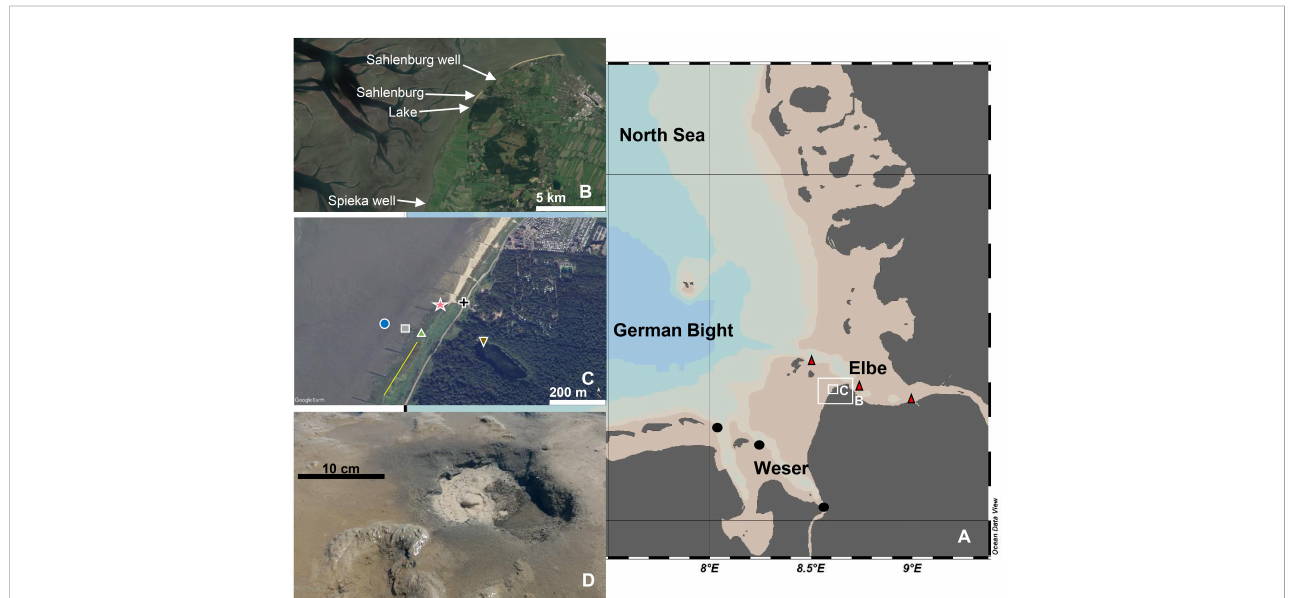
FIGURE 1 (A) Map of the German Bight with the Elbe and Weser estuaries. (B) Map of Sahlenburg, district of Cuxhaven, with sampling areas outlined by arrows. (C) Tidal fl at area with spring locations and other sampled areas. (D) Groundwater spring ( “ sand boil ” ) from Sahlenburg. The circle represents offshore, the square represents middle and the triangle represents nearshore springs, the inverted triangle represents the lake, the star represents the beach, and the cross represents water channel (ditch), respectively. The yellow line in (C) depicts the mean high water line. The map in (A) was made with Ocean Data View (Schlitzer, R., Ocean Data View, https://odv.awi.de, 2018), and the maps in (B, C) were made with Google Earth